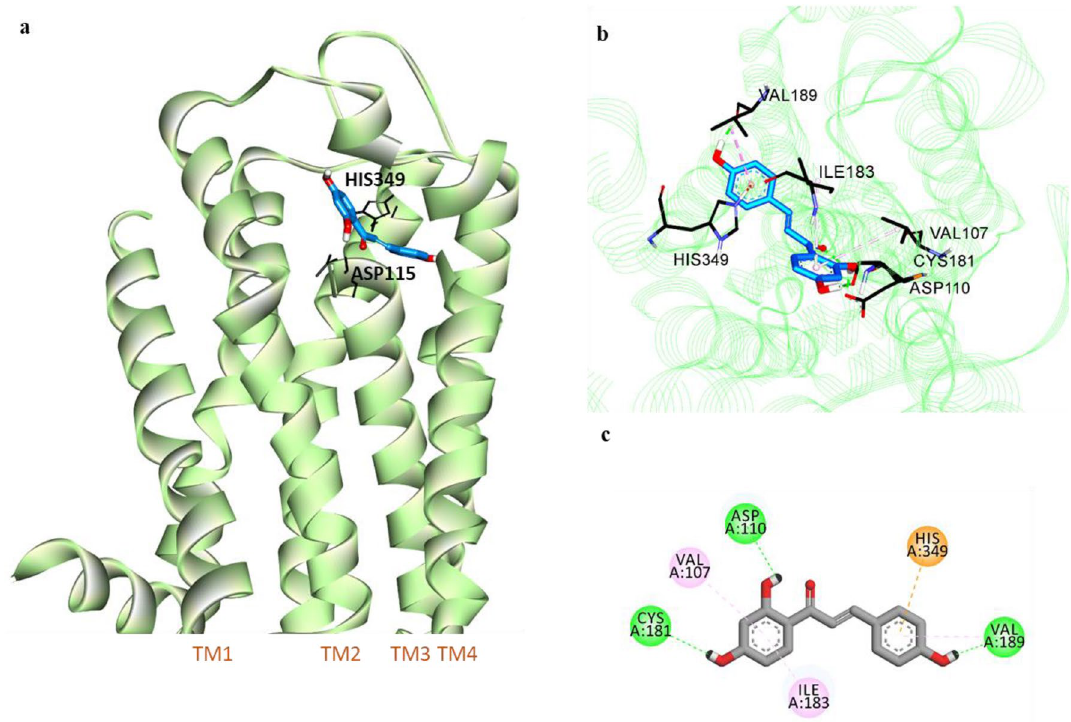
Figure 6. Molecular docking of isoliquiritigenin (ILG) (blue stick) to hD 3 R ( a ). Close-up view of ligand binding pocket of hD 3 R in complex with ILG ( b ). Two-dimensional binding diagram showing interactions of ILG-hD 3 R complex ( c ). H-bond, pi-alkyl, and pi-cation interactions are shown with green, light pink, and orange dashed lines,